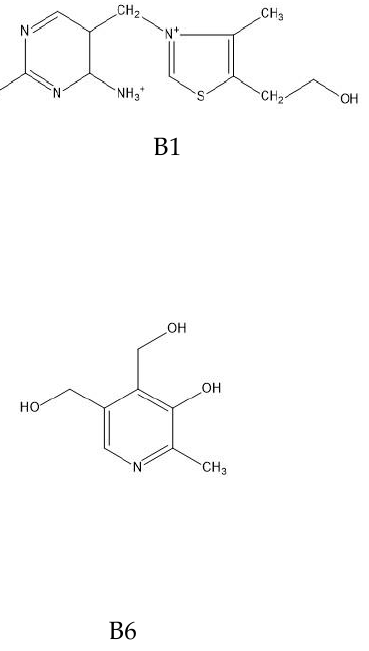
Figure 1. Chemical structure of the tested B vitamins.